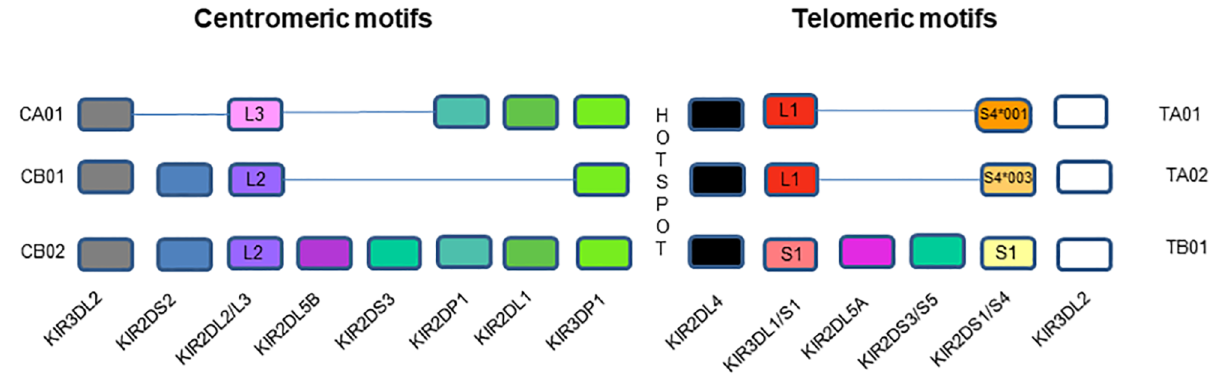
Fig 3. Killer Immunoglobulin-like (KIR) haplotypes. Organization and compositionof centromeric and telomeric KIR regiongenes.